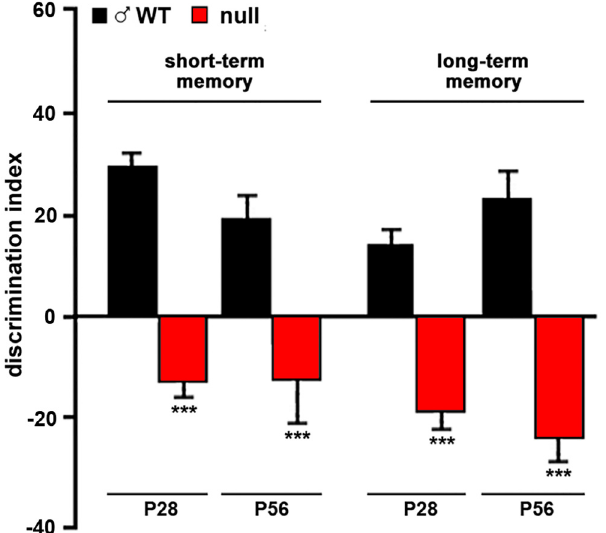
Fig 6. Cognition of CD1 Mecp2 -null animals is impaired. Cognition of CD1 wt and null animals was tested with the novel object recognition test. Animals were assayed at P28 (30 wt and 27 null) and P56 (17 wt and 10 null) and displayed strong impairments of both short and long term memory at both ages. Statistical significance was evaluated through Student ’ s t-test; *** = p <